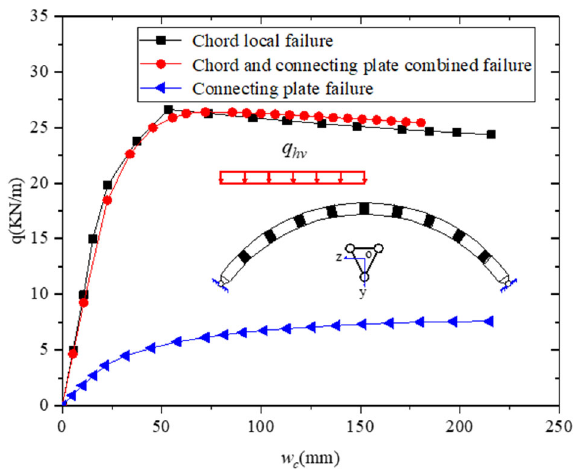
Figure 37. Load–displacement curves for three types of local failure modes under HSUVL.